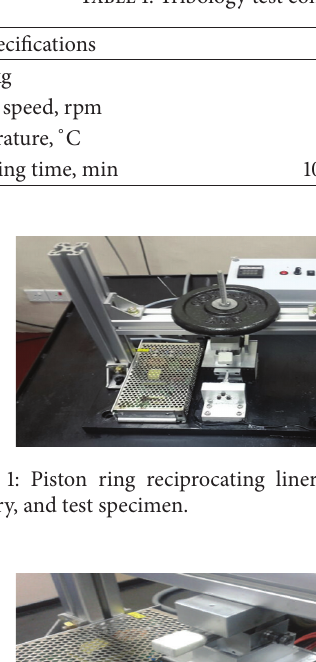
Table 1: Tribology test condition.